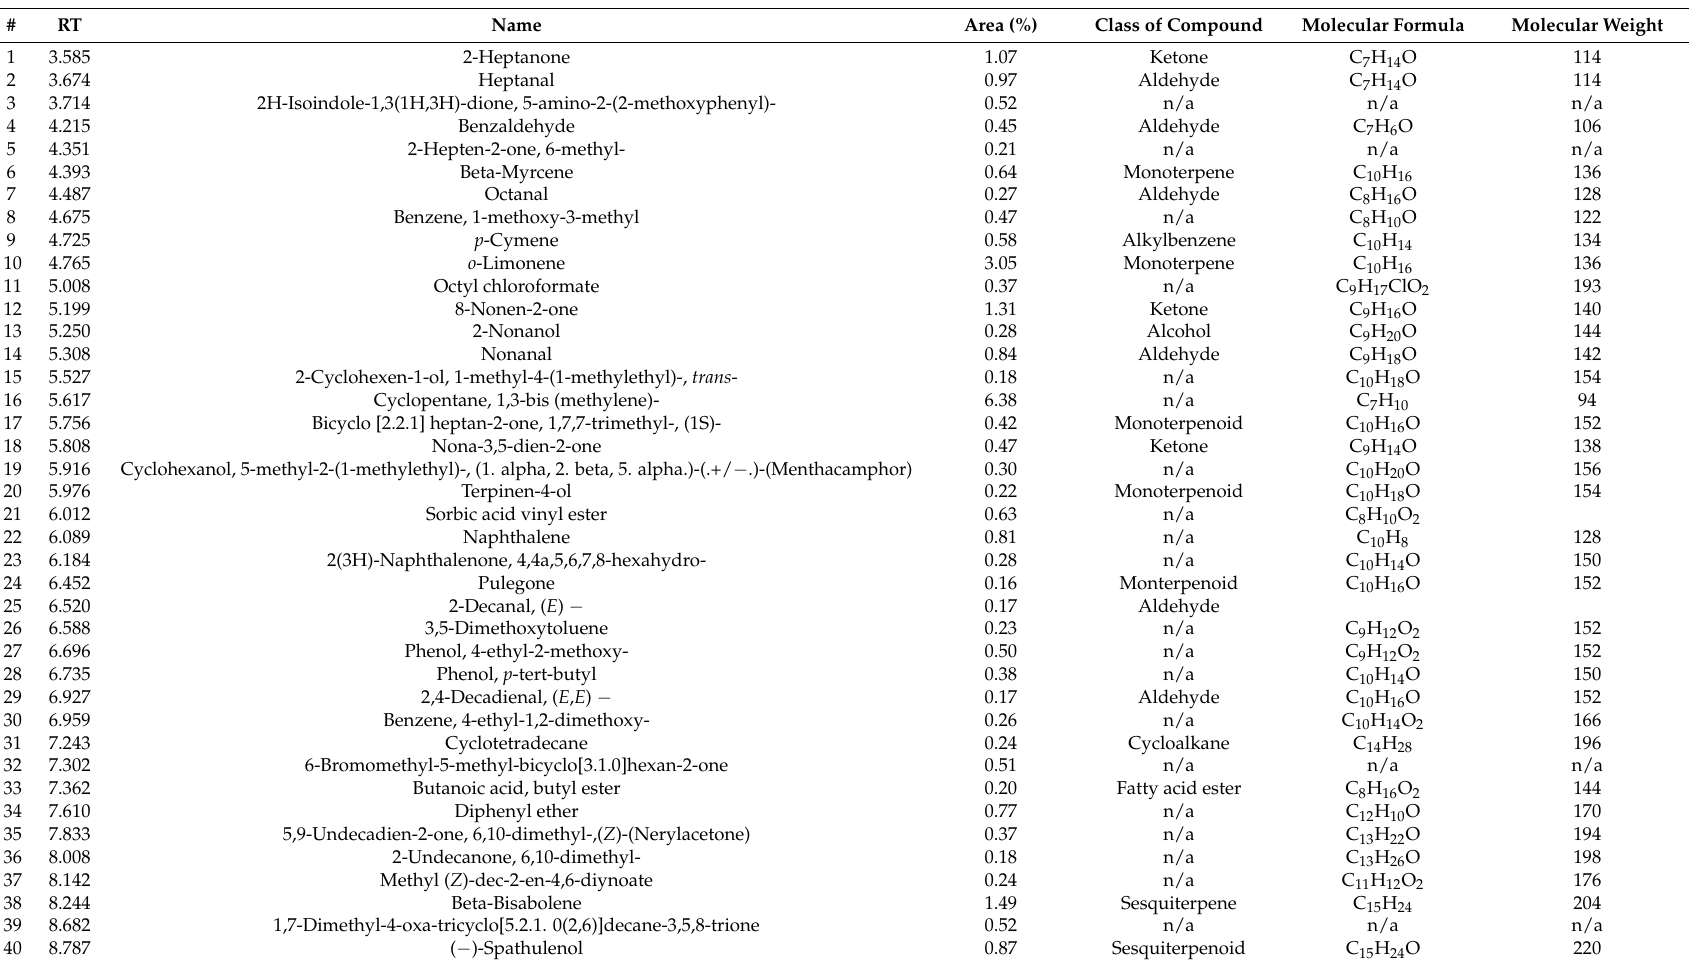
Table 5. Chemical composition of the essential oils of the root part of H. africana